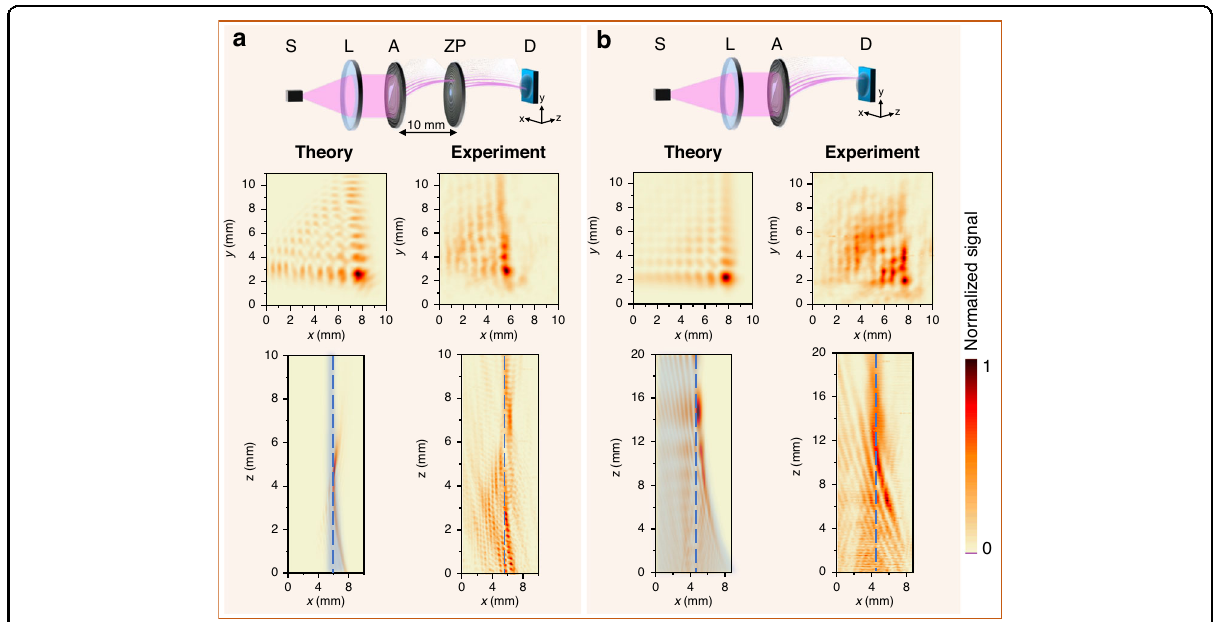
Fig. 2 Numerically estimated and experimentally obtained intensity distributions of the nonparaxial Airy beam in the transverse (xy) (at the focal point) and in the longitudinal (xz) planes at 0.6 THz. S denotes a THz source, L is a lens, A stands for the Airy phase mask, ZP is a nonparaxial zone plate, D labels THz detector. Panel a – using Airy phase mask with an additional zone plate. The distance between the Airy lens and the ZP is 10 mm, and for the transverse plane scan the detector is placed in 7 mm from the ZP. The starting scanning point along the z -axis is 1 mm away from the ZP; panel b – using the Airy lens only. The starting scanning point along the z -axis is 1 mm away from the Airy lens. Distributions are normalized to the maximum value of the signal. A dashed blue line in bottom panels – guide for an eye to accentuate Airy beam which exhibits parabolic trajectory. A light blue shaded area in theoretical plot enlightens the reciprocal trajectories. Note that in case of nonparaxial Airy generation with mask without zone plate (panel b ), the Airy pro fi le is not distorted as in the case with zone plate (panel a ) although the beam increases its dimensions as it propagates along the optical axis proportionally to z 2 . Reciprocal caustic trajectories following x ∼ 1/ z law are also nicely pronounced both in theory and experiment. As it is seen the experiments fi t well the modelling results (panel b